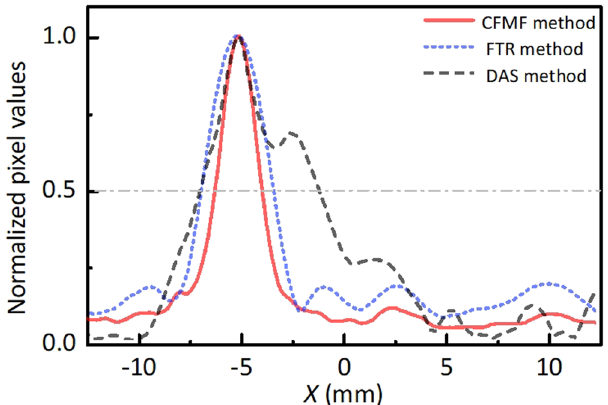
Figure 5. Image profile of the target obtained by three different imaging methods. Normalized pixel values in the focal plane at a depth Z = 87 mm (corresponding to source 2) of the CFMF method (red solid line), the FTR method (blue dotted line) and the traditional DAS method (black dashed line). The full width at half maximum (FWHM) of each method is measured by the grey dotted line. The CFMF method provides the smallest FWHM, which implies the best resolution.